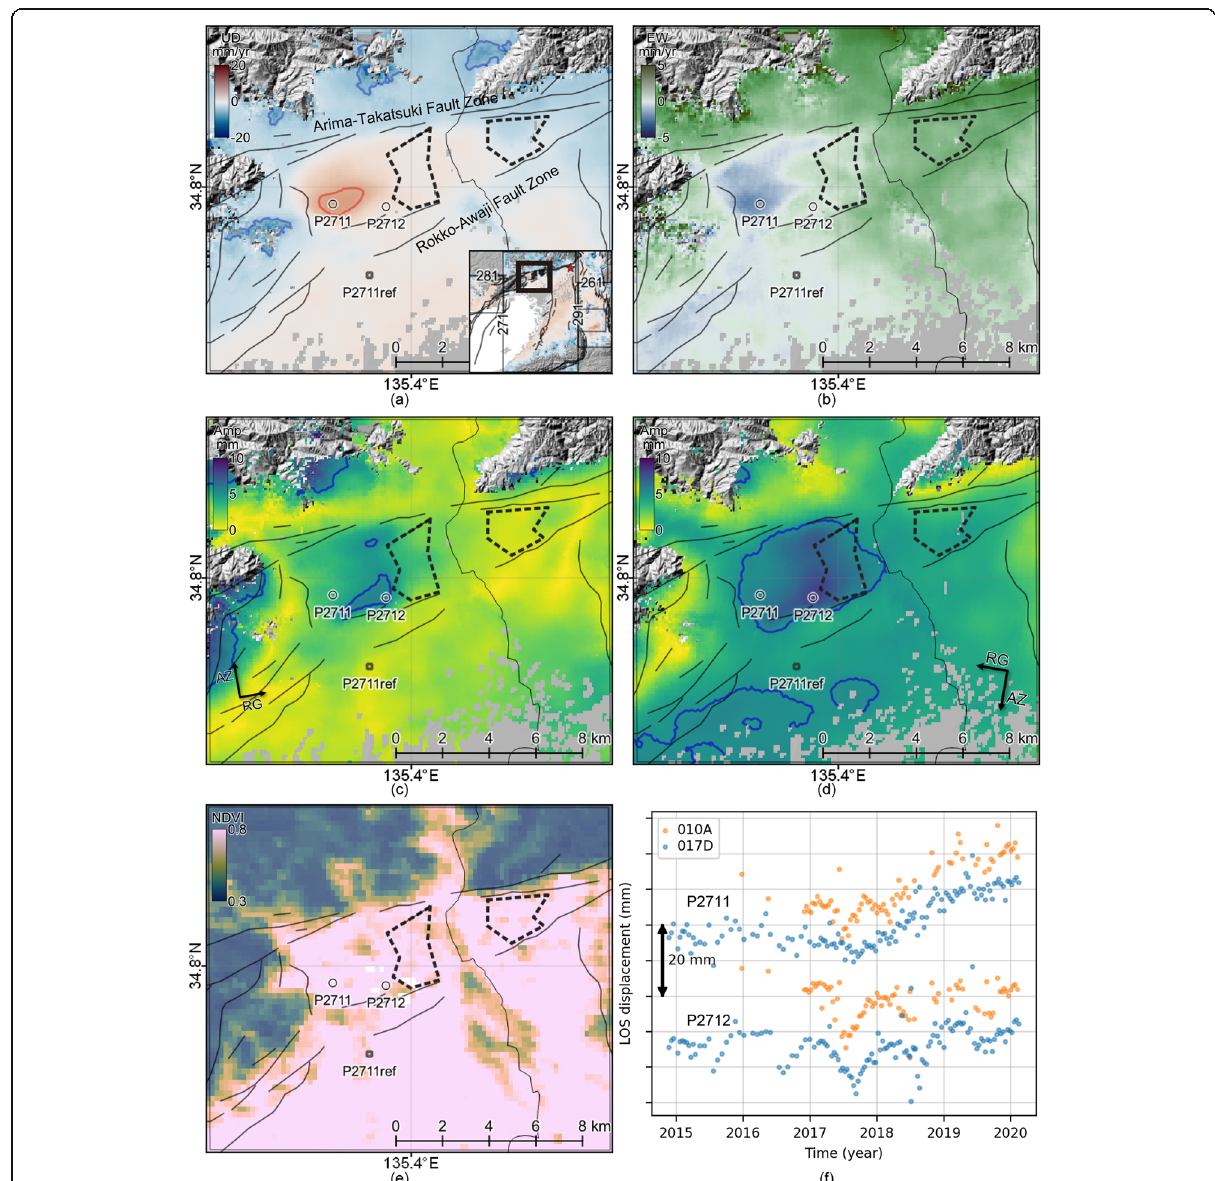
Fig. 14 a Vertical deformation velocities in a part of Osaka prefecture (ID: 271). The black solid lines denote the faults (The Headquarters for Earthquake Research Promotion 2020a, 2020b). The black bold dashed lines denote the outlines of the subsided areas until 2010 (Hashimoto 2016). The interval of the red (uplift) and blue (subsidence) contour lines is 5 mm/year without the 0 mm/year lines. The inset denotes the whole area of the 271 Osaka, and the red star denotes the epicenter of the Mw 5.6 earthquake on June 18, 2018. b EW deformation velocities. c Amplitudes of the annual LOS fluctuation from the ascending 010A_05549_121311. The interval of the contour lines is 5 mm. d Amplitudes from the descending 017D_05514_131312. e NDVI. f LOS deformation time series at P2711 and P2712 with reference to P2711ref for each